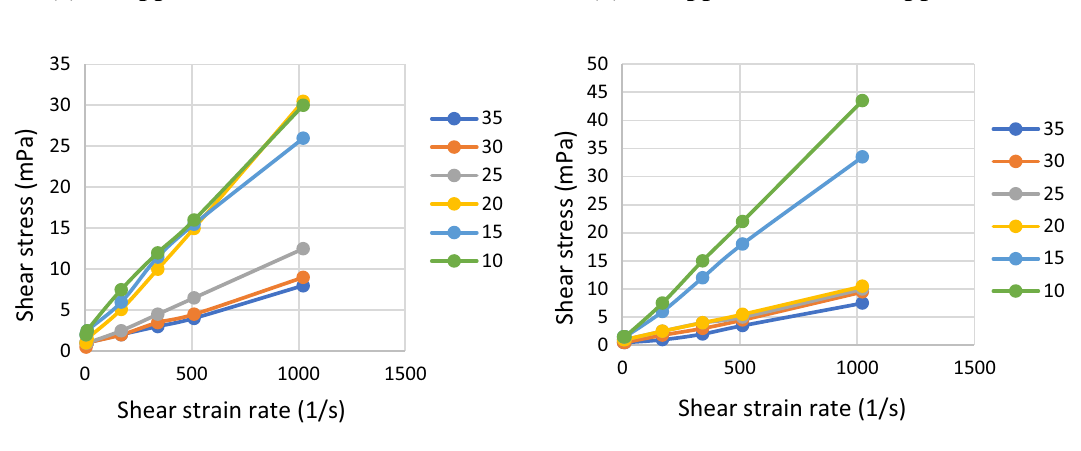
2 O 3 nanofluid, b 1000 ppm PEB and 100 ppm Al 2 O 3 , c 2000 ppm PEB and 100 ppm Al 2 O 3 , d 5000 ppm PEB and 100 ppm